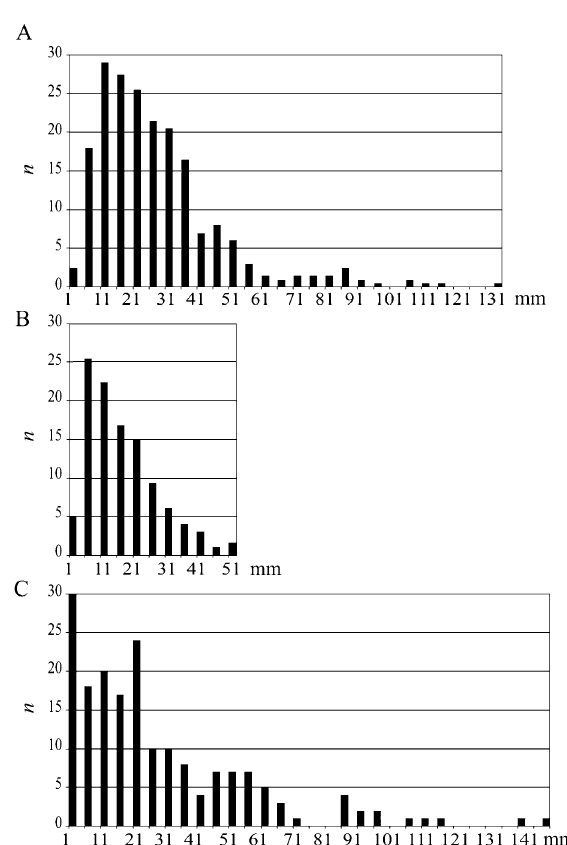
Fig. 3. Size-specific distribution of the fish fossils from the Kl ū nas site, according to data of excavations of 2010. A , the 1st oryctocoenosis; B , the 2nd oryctocoenosis; C , the 3rd oryctocoenosis; n , the number of